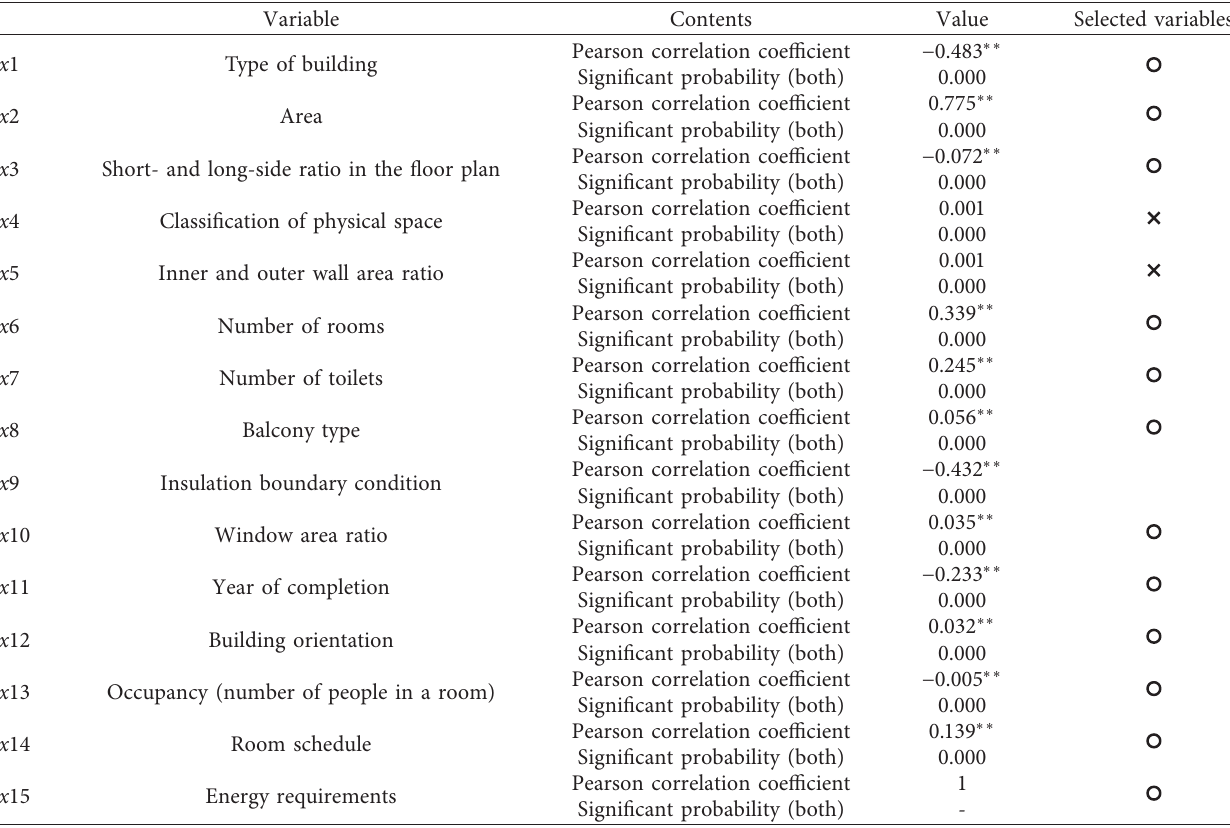
Table 11: Results of sensitivity analysis.